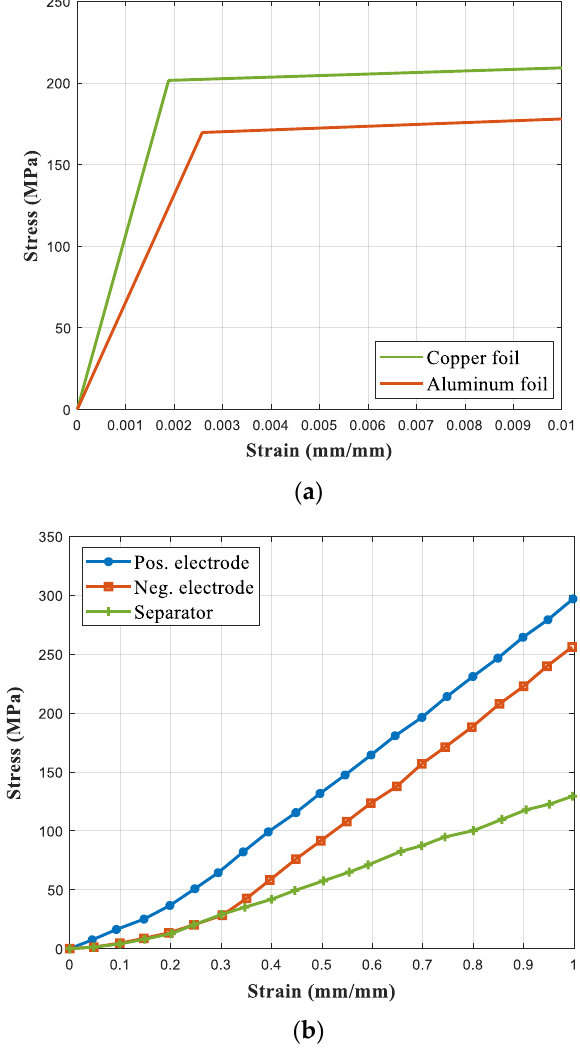
Figure 4. The stress – strain curves: ( a ) current collectors; ( b ) active material and separators [9]. Reproduced from [9], Zhang et al.: 2015. Table 1. Material properties of LIB components [9,20]. Reproduced from [9,20], Zhang et al., Gu et al.: 2015, 2000.